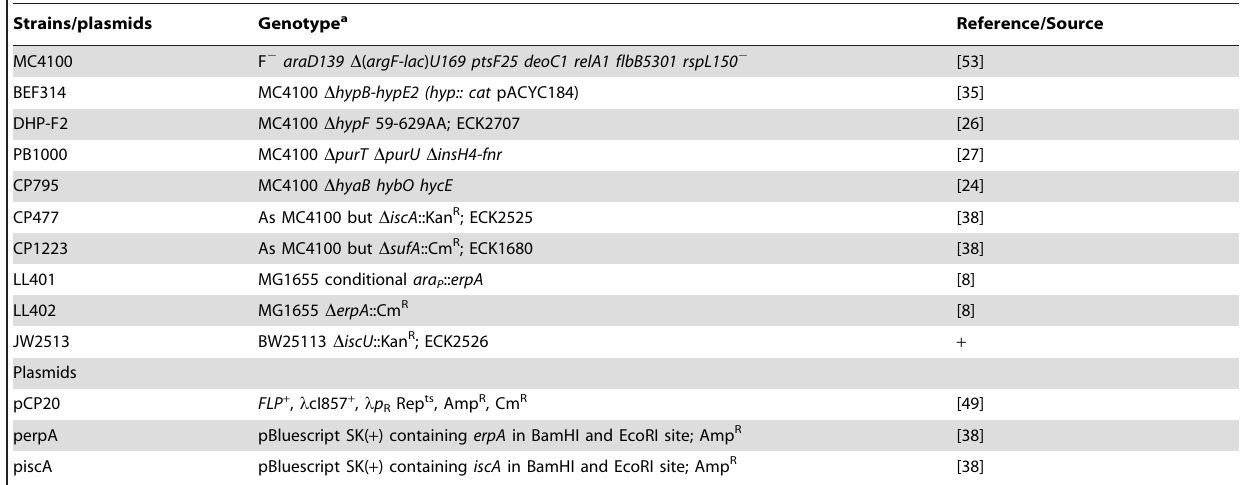
Strains/plasmids Genotype